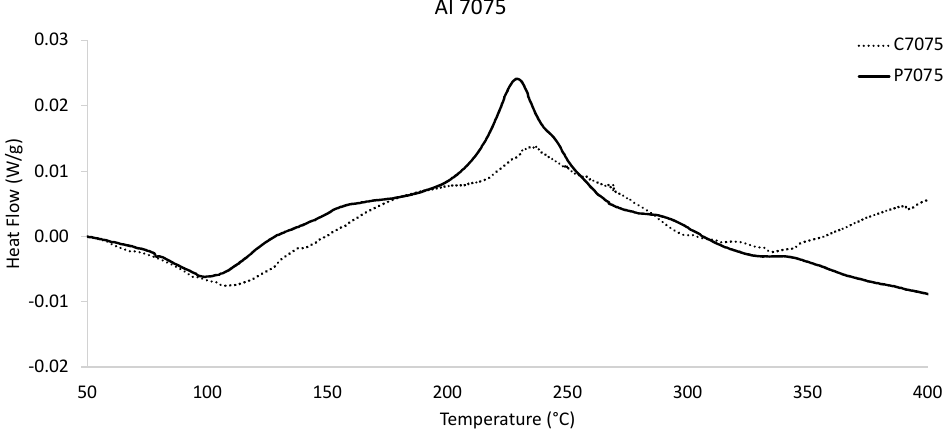
Figure 7. Differential scanning calorimetry-derived heat flow versus temperature curves for the as-cast as well as the as-atomized Al 7075 materials.